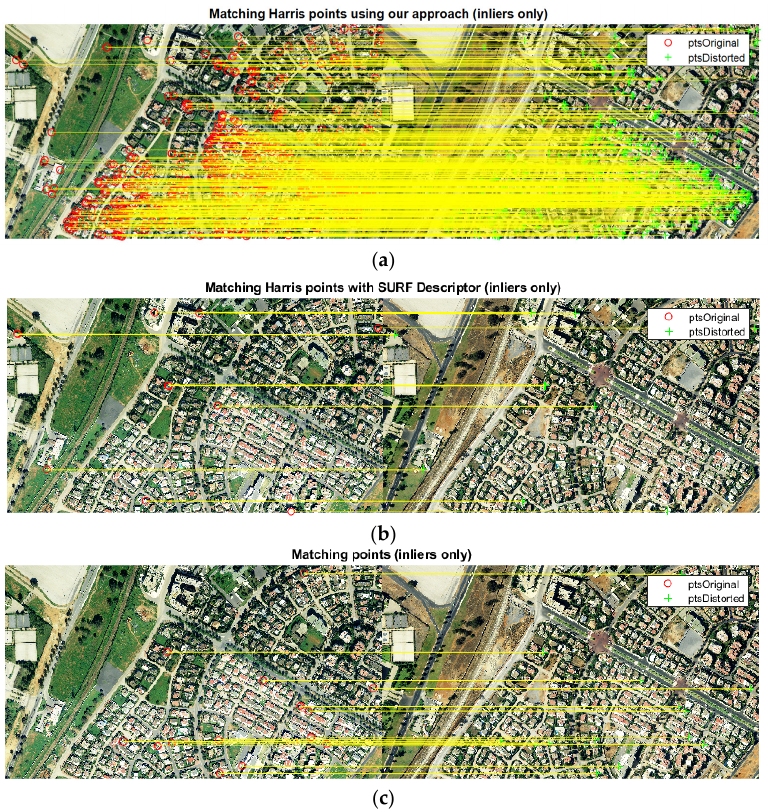
Figure 4. Matching result comparison after RANSAC for aerial imagery 2014–2016: ( a ) our approach without optimization, ( b ) Harris corners with SURF descriptor, ( c ) SURF-based method. (SURF corners with SURF descriptor). The success of the proposed approach is largely due to the use of the Blackman and Hann windows, which avoid edge effects by using patches of 16 × 16 pixels and the RAN- SAC algorithm to deal with outliers; the larger patch size increases the number of incor- rectly matched point. To obtain this performance for the corresponding algorithm, the results of many phase matching trials were examined for various experimental conditions.